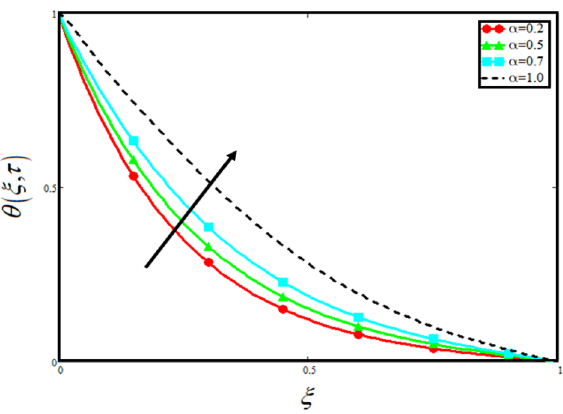
Figure 3. Variation in temperature against different values of α when τ = 1 , φ hnf = 0.02 , Pr = 21 and Re = 1.2 .